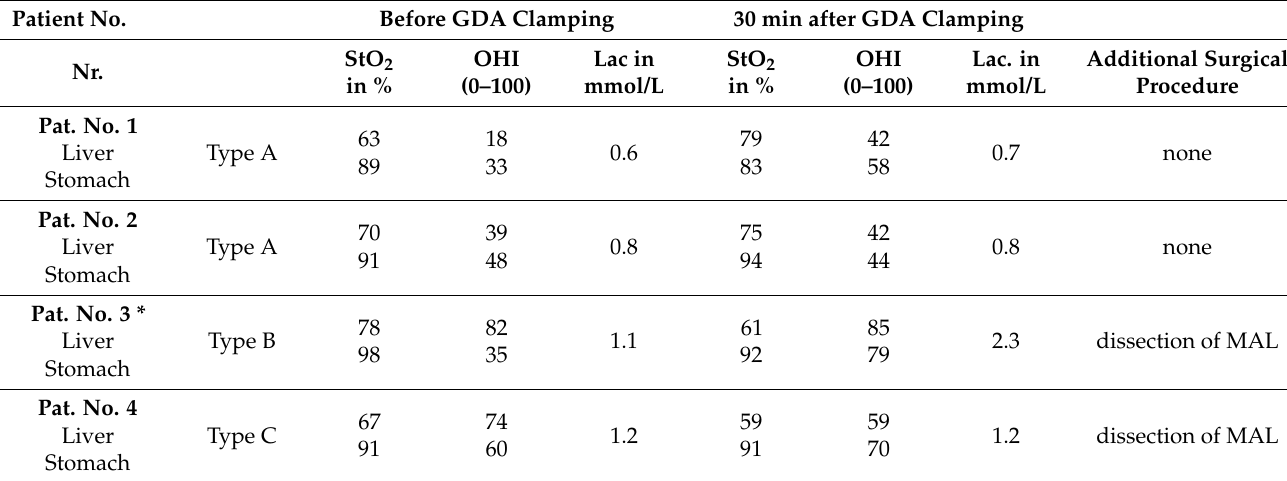
Table 4. HSI measurements of liver and stomach in patients with CAS.